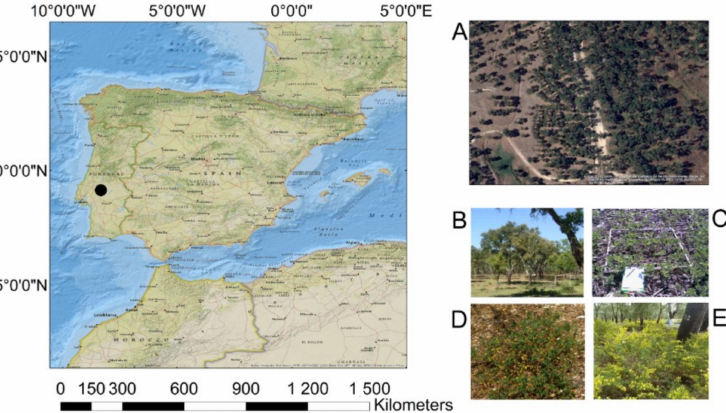
Figure 1. Study area located in Machoqueira do Grou, Coruche, Portugal, whose land use consists of a cork oak woodland ( A ) composed of cork oak trees ( B ), herbaceous vegetation ( C ), Cistus salvifolius ( D ) and Ulex airensis ( E ).